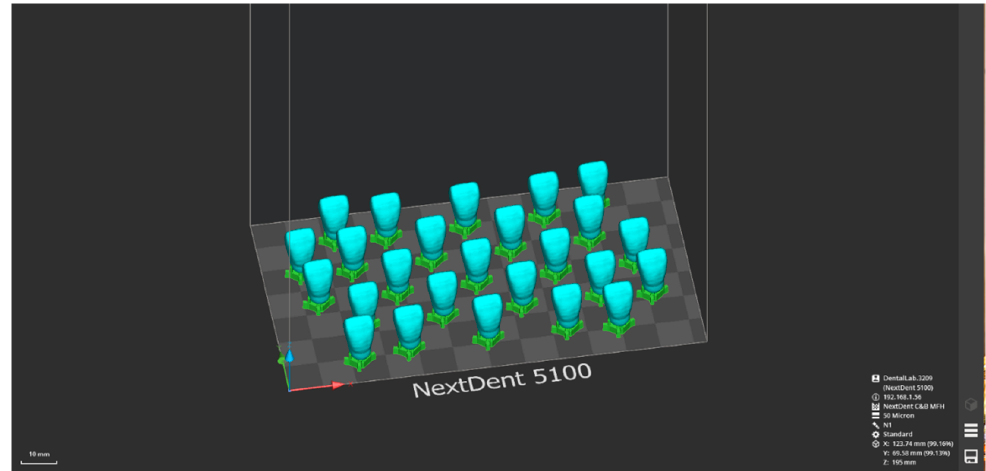
Figure 1. Digital three dimensional (3D) model of the artificial teeth used in this study (NextDent 5100, NextDent, 3D systems, The Netherlands).